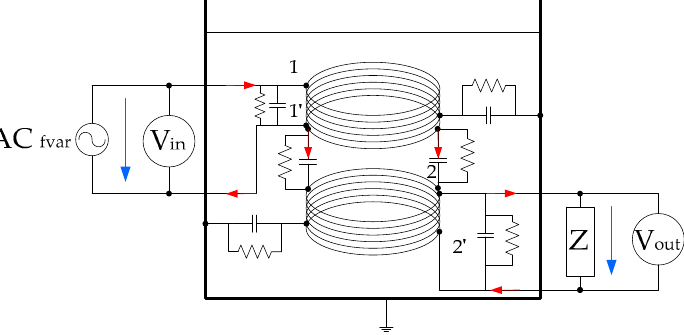
Figure 3. FRA test fluid core dual-coil sensor simplified circuit.